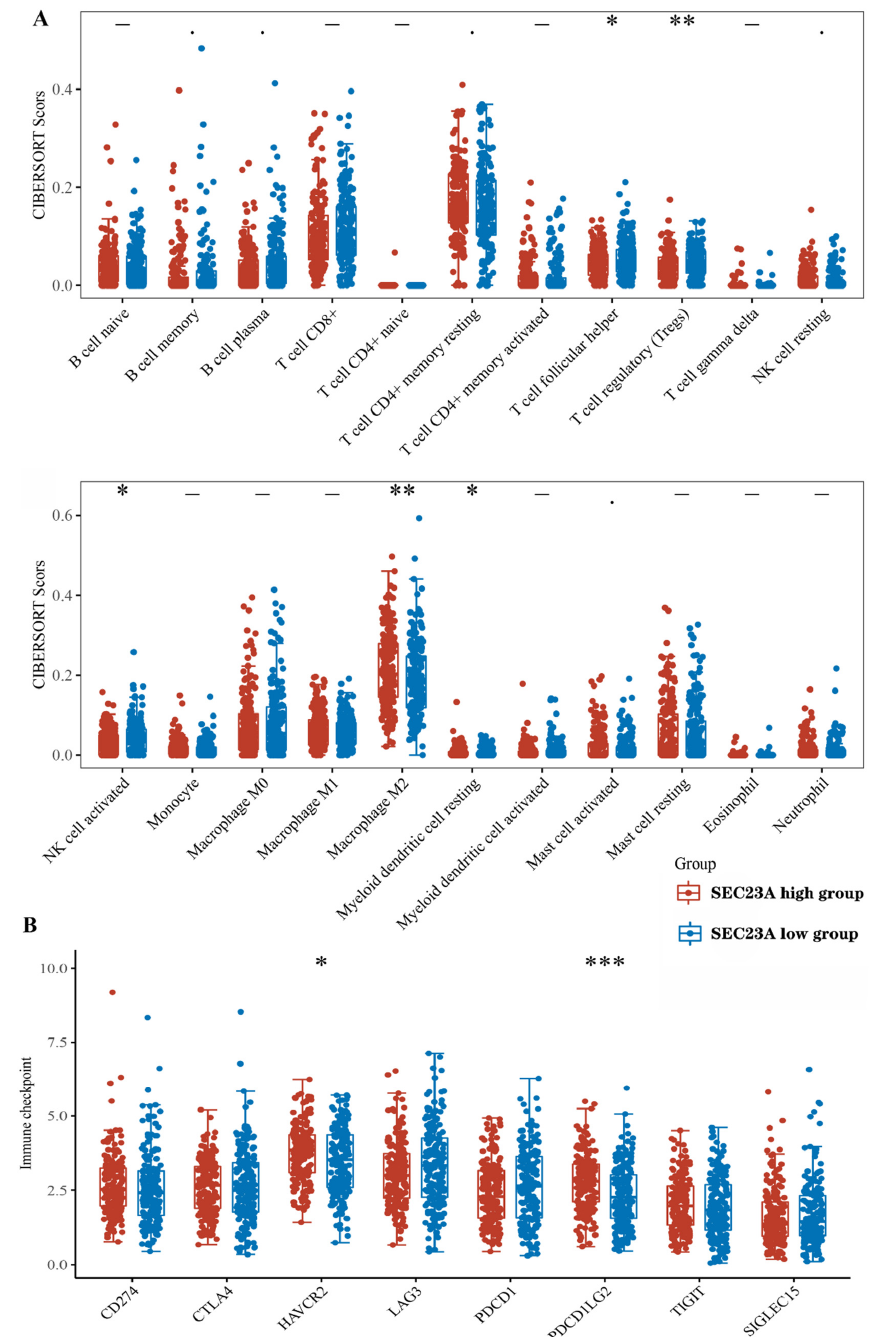
Figure 6. Tumor-infiltrating immune cell subsets and expression of checkpoint-related genes (* p < 0.05, ** p < 0.01, *** p < 0.001). Tumor-infiltrating immune cell subsets of the high and low SEC23A expression groups ( A ). Immune checkpoint molecule-related gene expression in the high and low SEC23A expression groups ( B